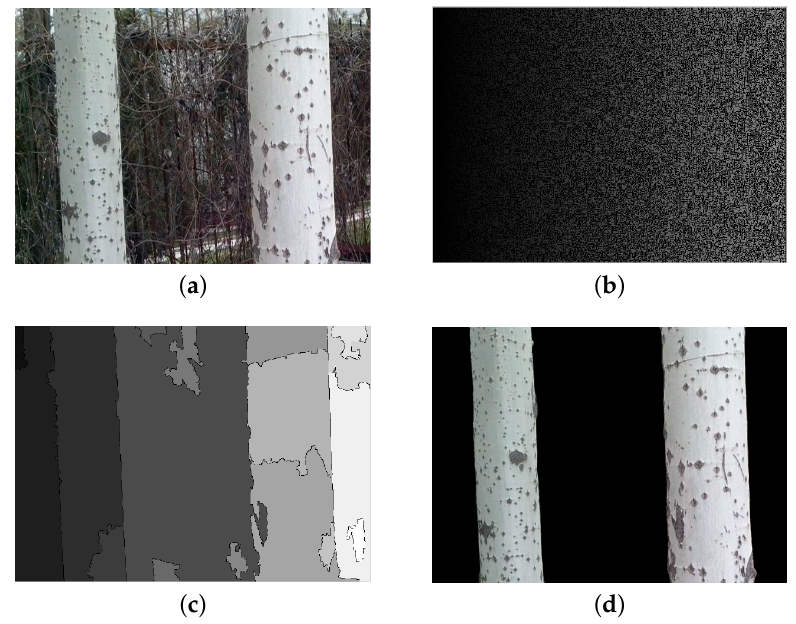
Figure 19. The results of the watershed algorithm. ( a ) Original image. ( b ) Traditional watershed algorithm. ( c ) Improved watershed algorithm. ( d ) Proposed marker-controlled watershed